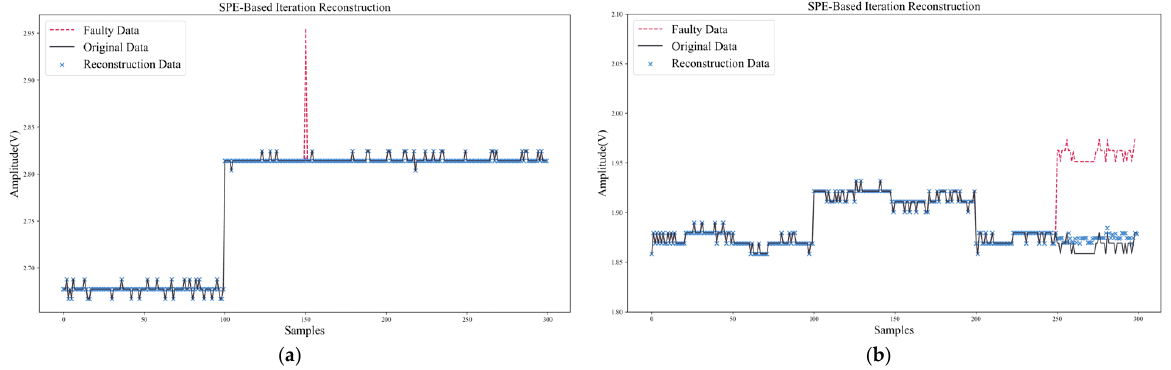
Table 8. Data Recovery Error (MAE/MAPE) of Different Reconstruction Methods. Figure